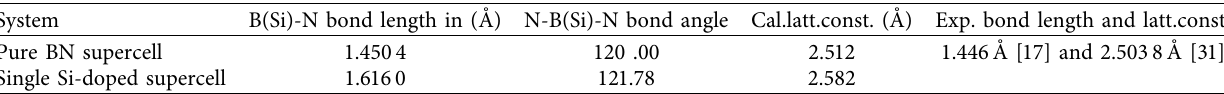
Table 1: The calculated B(Si)-N bond length, B(Si)-N-B(Si) bond angle, the calculated lattice constant (Cal.latt.const.), and the experimental lattice constant (Exp.latt.const.) of pure and silicon-doped monolayer boron nitride